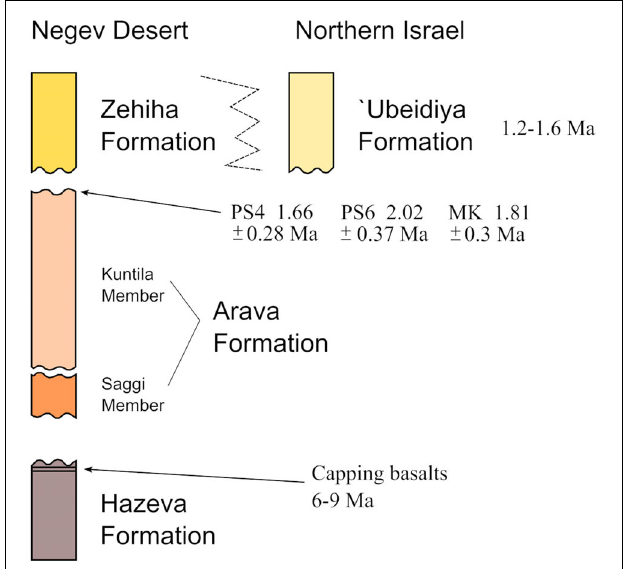
FIGURE 2 | Sketch showing the arrangement and lateral equivalences of the different formations discussed in the text. PS4, PS6 and MK indicate exposure ages (Matmon et al., 2009; Amit et al., 2011; Guralnik et al.,